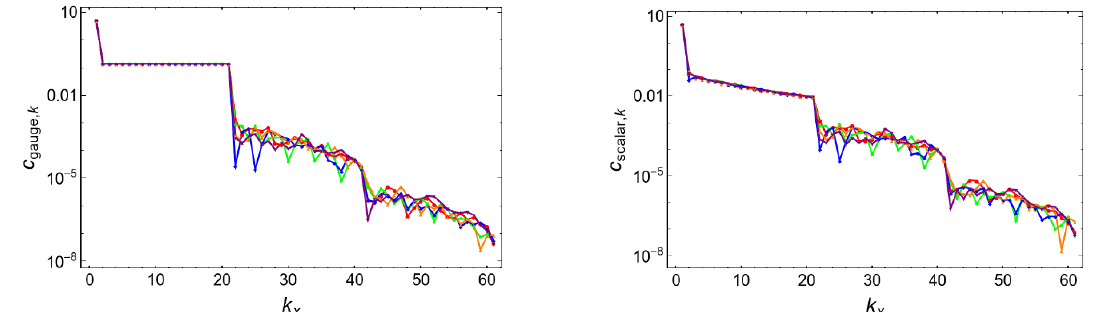
Figure 13 . Example coe(cid:14)cient convergence plot for the gauge (cid:12)eld (left) and scalar (cid:12)eld (right) for (cid:12)ve randomly chosen samples at M = 10 : 1, (cid:22) (cid:13) = 0 : 45, A M 0 = 0 : 1, b off = 1 : 0: maximum absolute normalized Fourier coe(cid:14)cient c k = 1 the sine/cosine representation) as a function wave number k x , where the maximum is taken over the remaining z